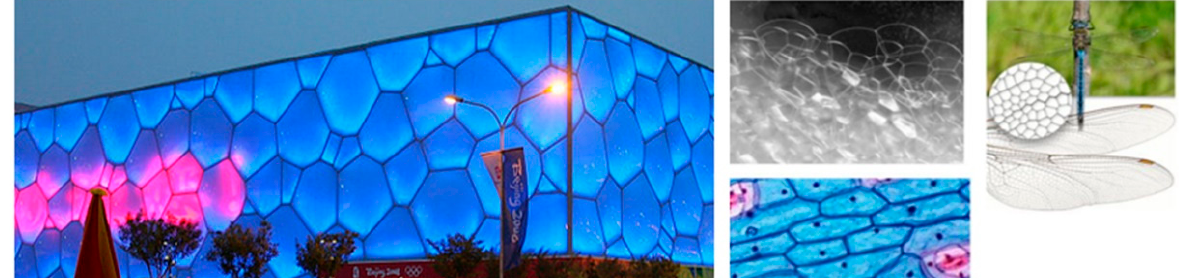
Figure 27. Examples of Voronoi applications.